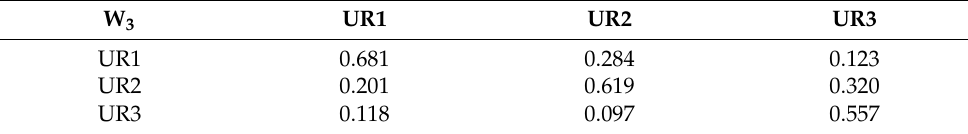
Table 10. Relative weights of URs with respect to each UR (W 3 ).